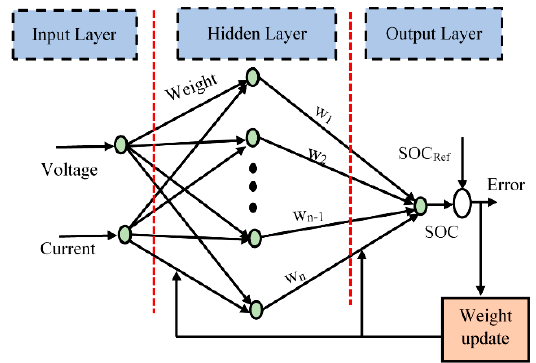
Figure 5. Structural design of the proposed BPNN algorithm.